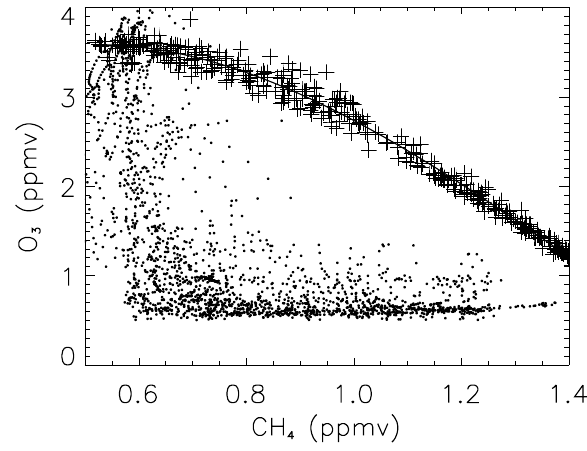
Fig. 7. Relationship between CH 4 and O 3 volume mixing ratios in the Northern Hemisphere stratosphere for the winter 1996–1997 as modelled by STRATAQ CTM. The data encompass potential tem- perature ranges from 400K to 650K, but exclude points outside the vortex. Plus signs indicate CTM data for 30 November 1996, while black dots indicate CTM data for 20 March 1997. The black solid line shows the relation derived from the November